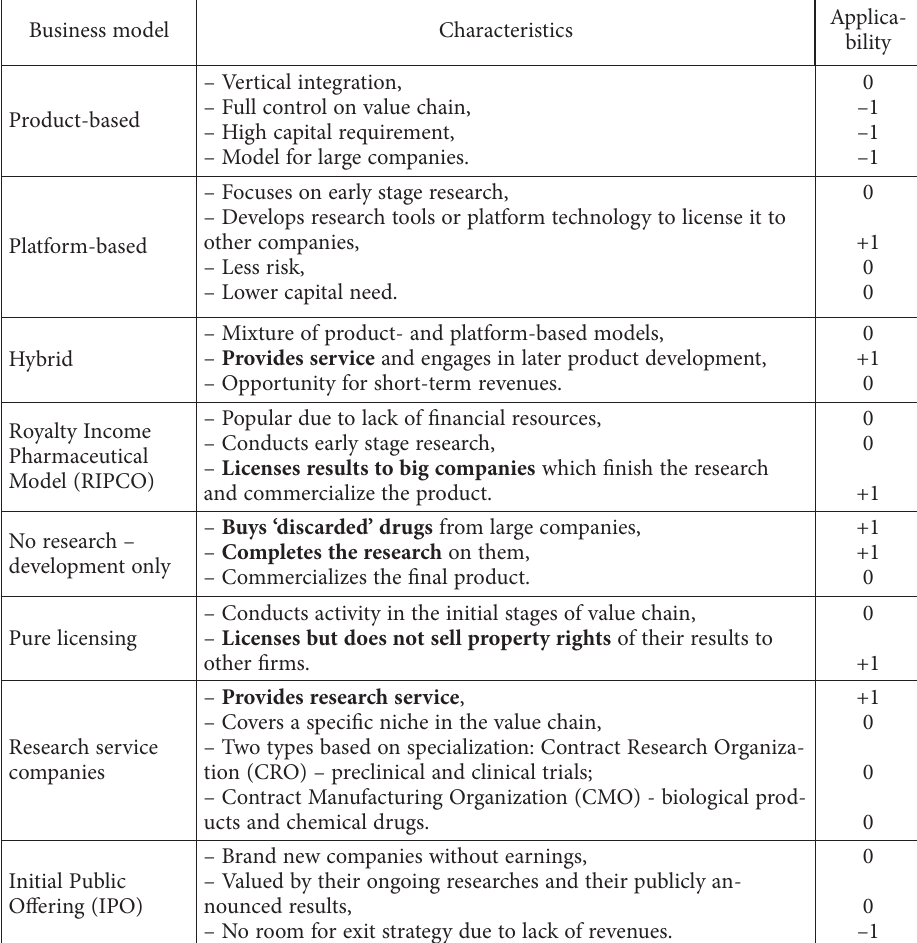
Table 2. The closed business models of the Belgian pharmaceutical biotech industry (source: self-made based on Segers, 2017) Business